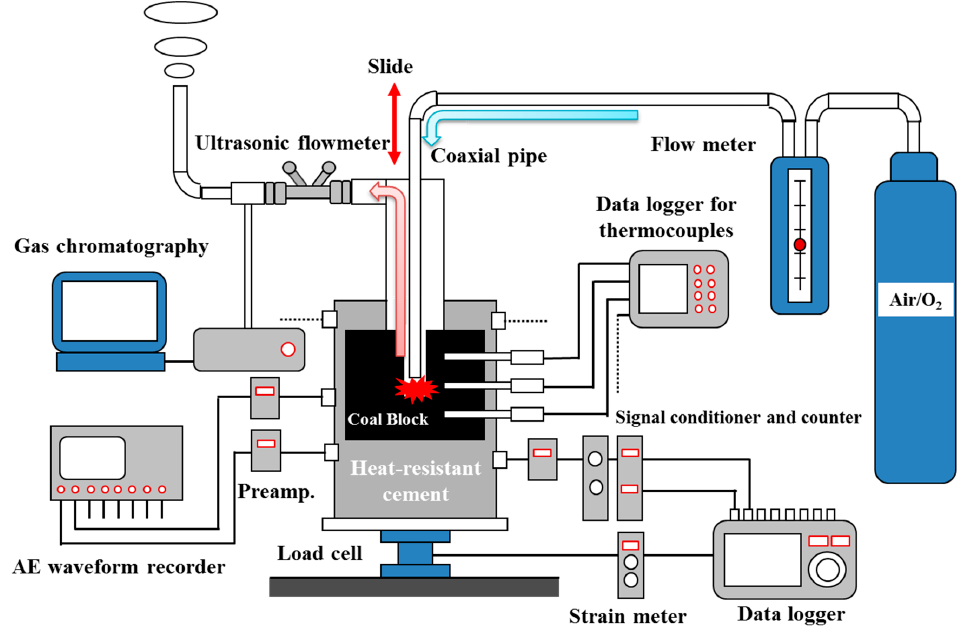
Figure 3. A diagram of the UCG model experiment. Table 1. Proximate and ultimate analyses of the coal.